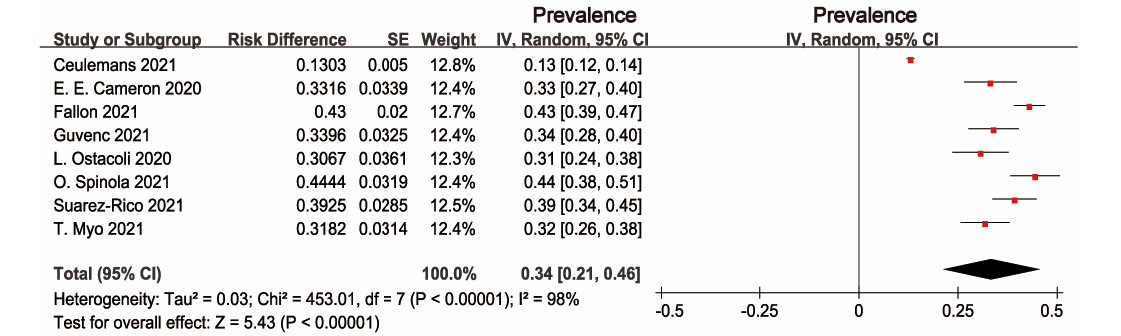
Figure 2. Forest plot of prevalence estimates of postpartum depressive symptoms.